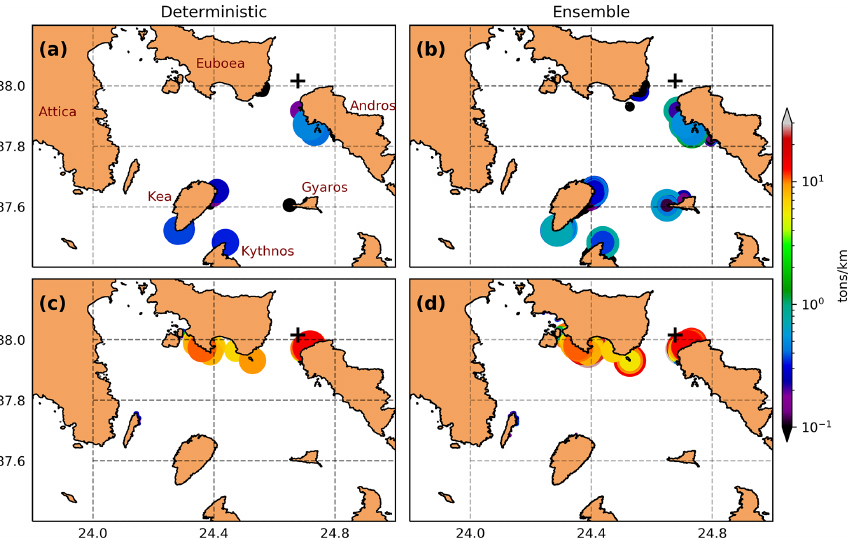
Figure 11. Beached oil concentrations (API 31; t/km) at the end of the run, i.e., forecast time 168h, during (a–b) winter and (c–d) spring for the (a, c) deterministic and the (b, d) ensemble considering all members.